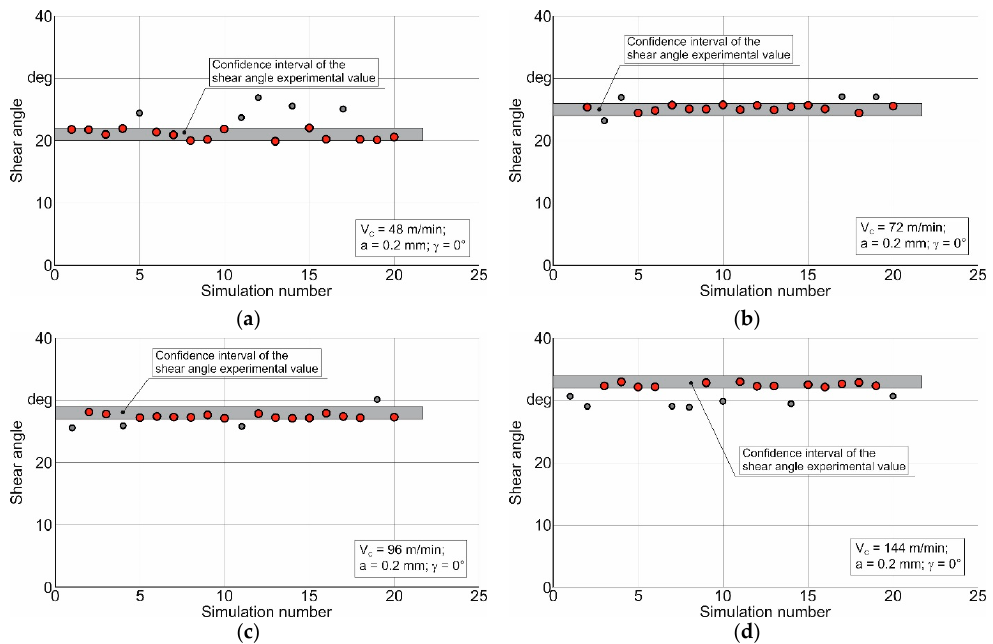
Figure 10. Second iteration of the simulated shear angle distribution relative to its experimental values for different cutting speeds: ( a )—cutting speed 48 v/min; ( b )—cutting speed 72 m/min; ( c )—cutting speed 96 m/min; ( d )—cutting speed 144 m/min.